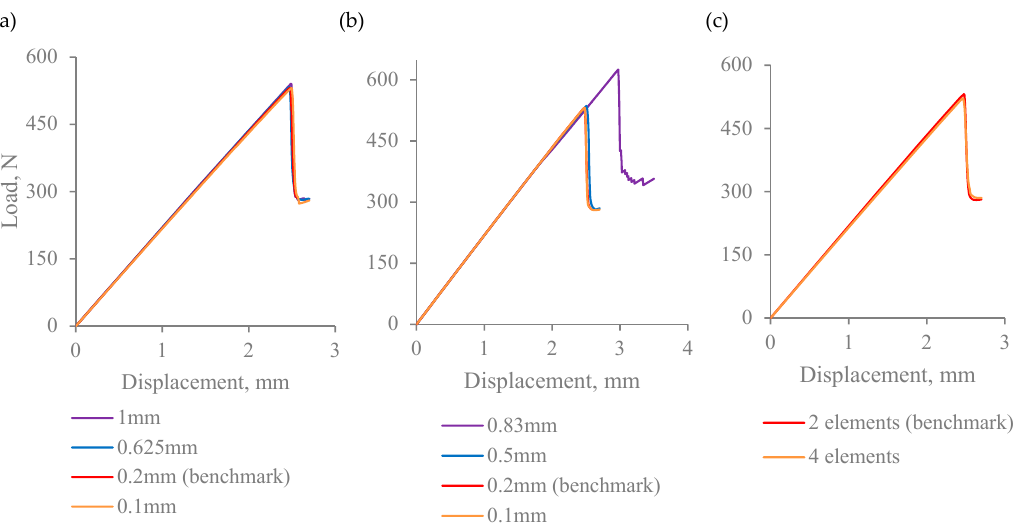
Figure 11. Mesh sensitivity study for the Mode II model, when the mesh is refined ( a ) along the length of the beam; ( b ) along the width of the beam; and ( c ) in a thickness direction.